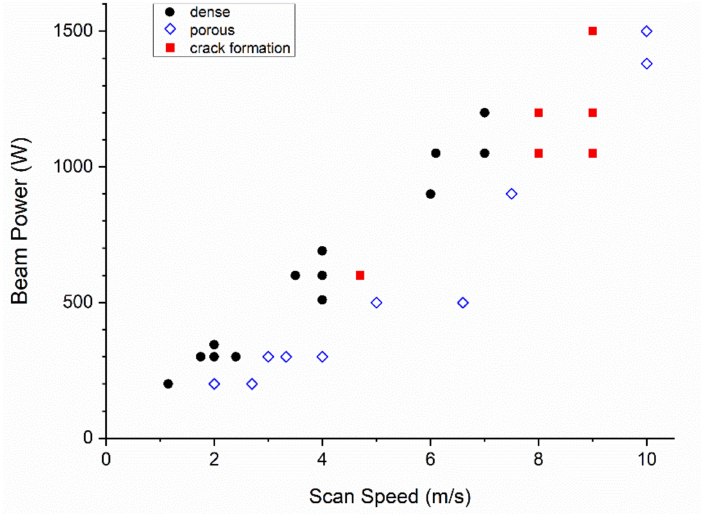
Figure 2. PBF-EB process window for X65MoCrWV3-2 for 70 µ m layer thickness and 50 µ m hatch distance. Full circles mark dense specimens, while open diamonds stand for porous materials and full squares for materials with